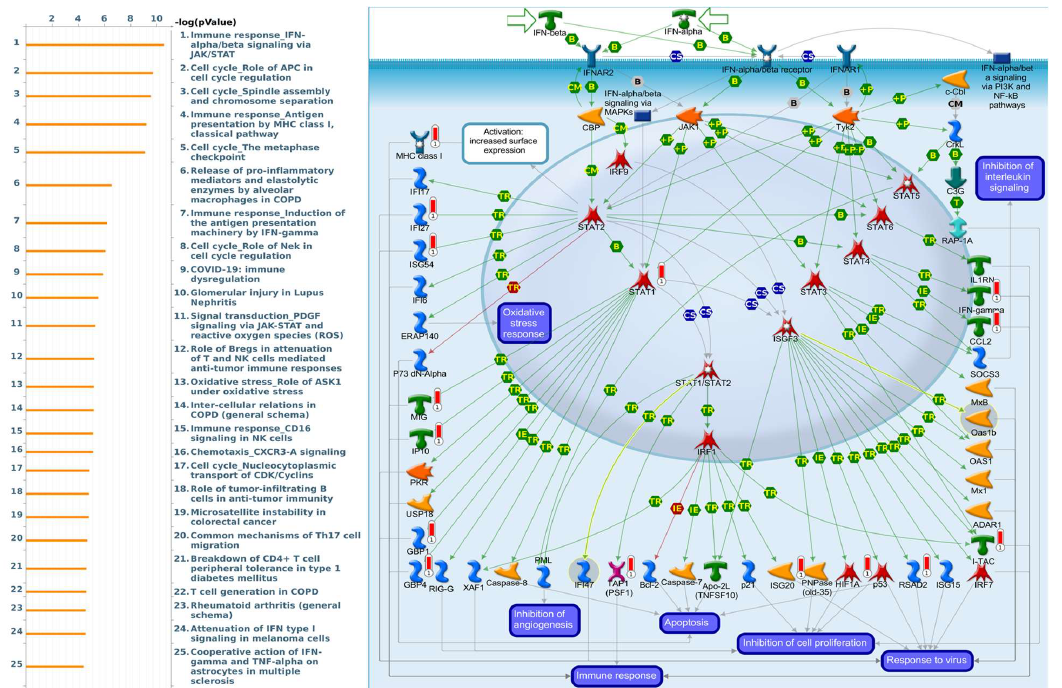
Figure 8. MetaCore pathway analysis of the coexpression gene network of proteasome 20S subunit alpha 4 (PSMA4) in breast cancer patients. We used the MetaCore platform to analyze genes coexpressed with PSMA4 from the associated METABRIC and TCGA datasets, and downstream pathway analyses revealed that “Immune response_IFN-alpha and beta signaling via JAK/STAT” participates in breast cancer development.